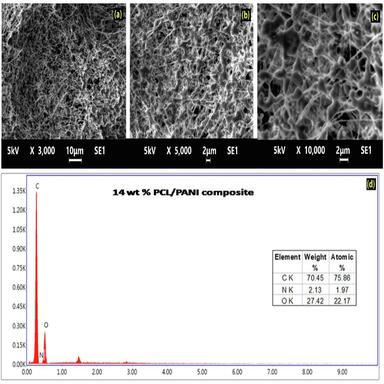
SEM and EDX images of 14 wt% (a, b, c, d) PCL and PANI composites.